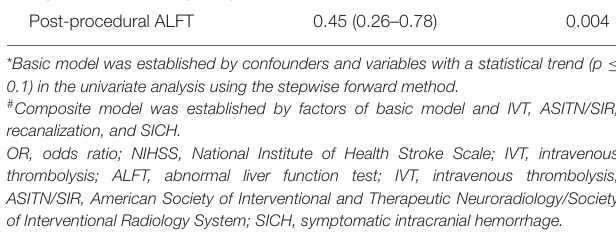
Supplementary Figure 1 . The demographic characteristics